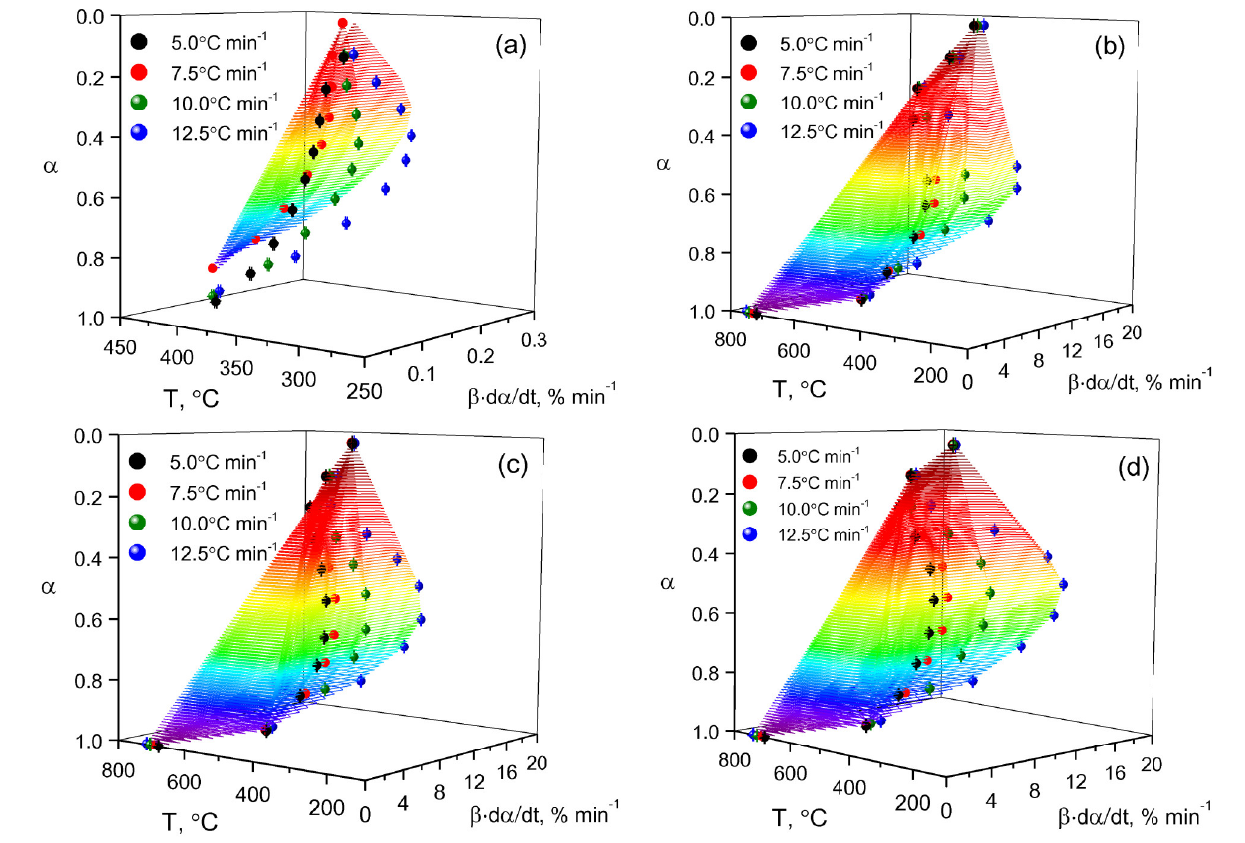
Figure 7. p-PGFPh:АА copolymers surface in 3D space: reaction ( tα dd  ) speed dependence on Figure 7. p-PGFPh:AA copolymers surface in 3D space: reaction ( β · d α /dt) speed dependence temperature (Т) and conversion rate ( α ). ( a )−p-PGFPh; ( b )−6.77:93.23; ( c )−44.17:55.17; and on temperature (T) and conversion rate ( α ). ( a )—p-PGFPh; ( b )—6.77:93.23; ( c )—44.17:55.17; and ( d )−86.67:13.33. ( d